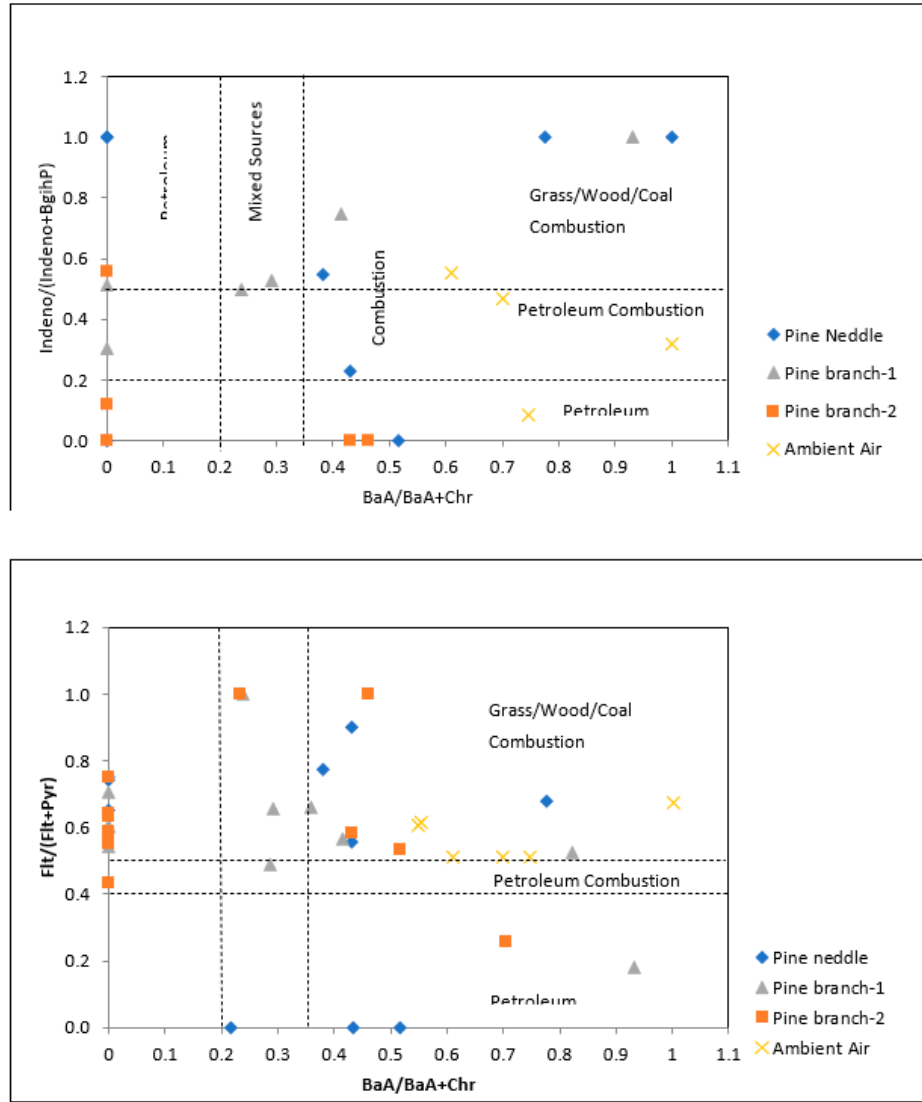
Figure 5. PAH cross-plots for the ratios of Indeno/(Indeno+BghiP) and Flt/(Flt+Py) against BaA/(BaA+Chr) ratios in the studied tree components and ambient air. Note: Pine branch-1 and Pine branch-2 refer to 1-year-old and 2-year-old branches.